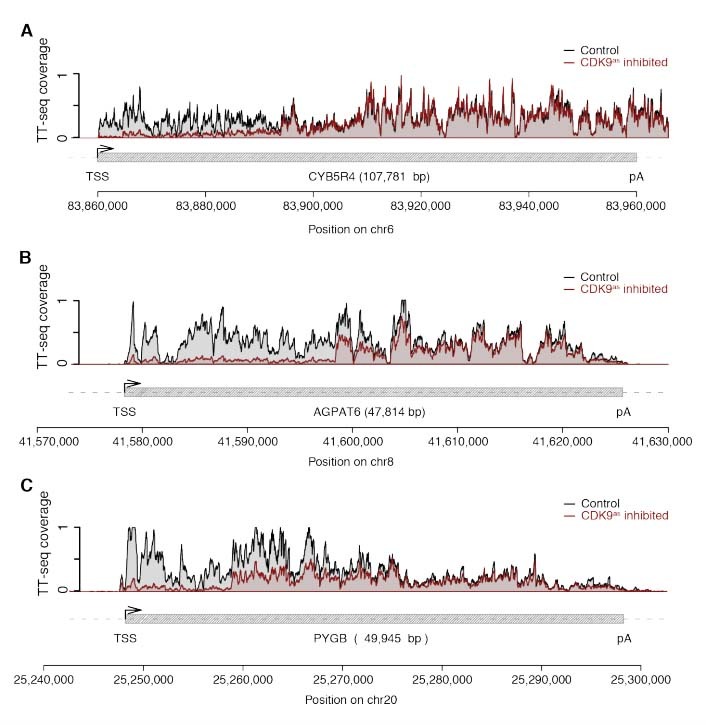
Example genome browser views of TT-seq signals in CDK9as cells with high responsiveness (~ 90%).(A) CYB5R4 gene locus (107,781 [bp]) on chromosome 6. The upper panel shows TT-seq signal with CDK9as inhibitor (red) and control (black). Grey box depicts transcript body from transcription start site (TSS, black arrow) to polyA site (pA). (B) AGPAT6 gene locus (47,814 [bp]) on chromosome 8 depicted as in (A). (C) PYGB gene locus (49,945 [bp]) on chromosome 20 depicted as in (A).